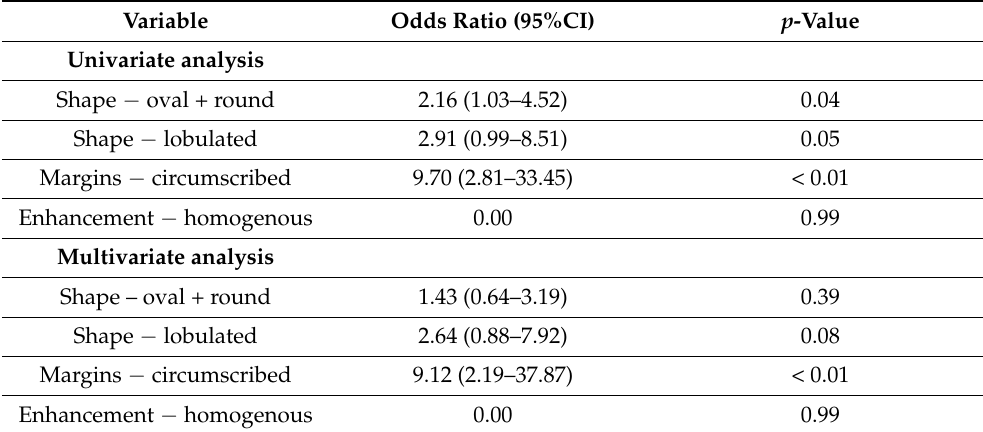
Table 3. Odds ratio for TNBC on univariate and multivariate